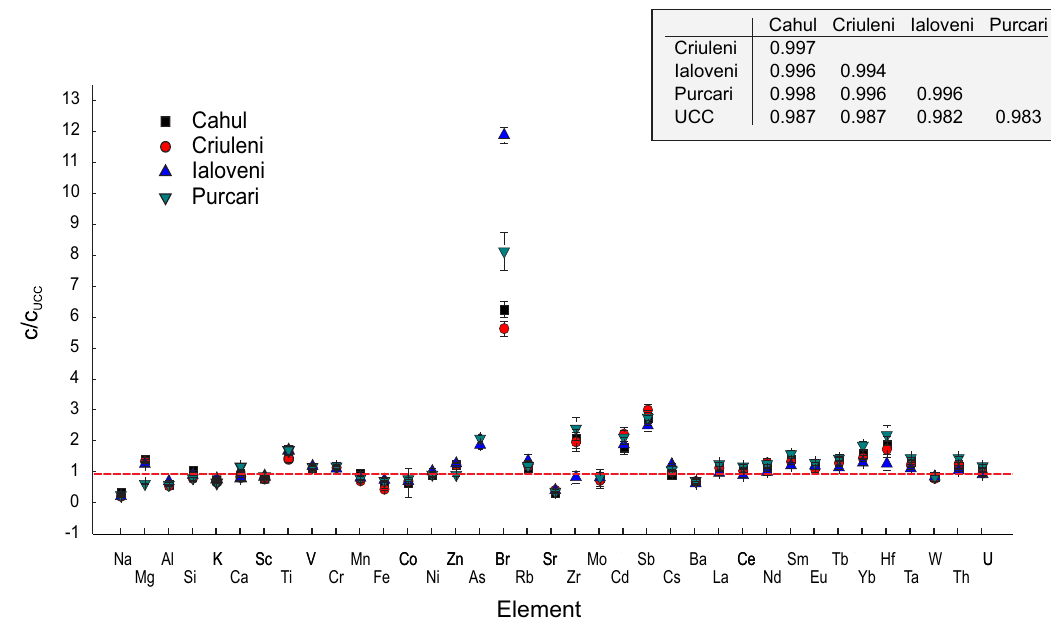
Figure 2. Mass fractions of major and trace elements (mass fractions ± 1 SD) in soil samples normalized to the UCC [23]. The inset reproduces the Spearman’ ρ correlation coefficient matrix with Bonferroni correction at p < 0.01 calculated for all element except Br, Zr, Cd, and